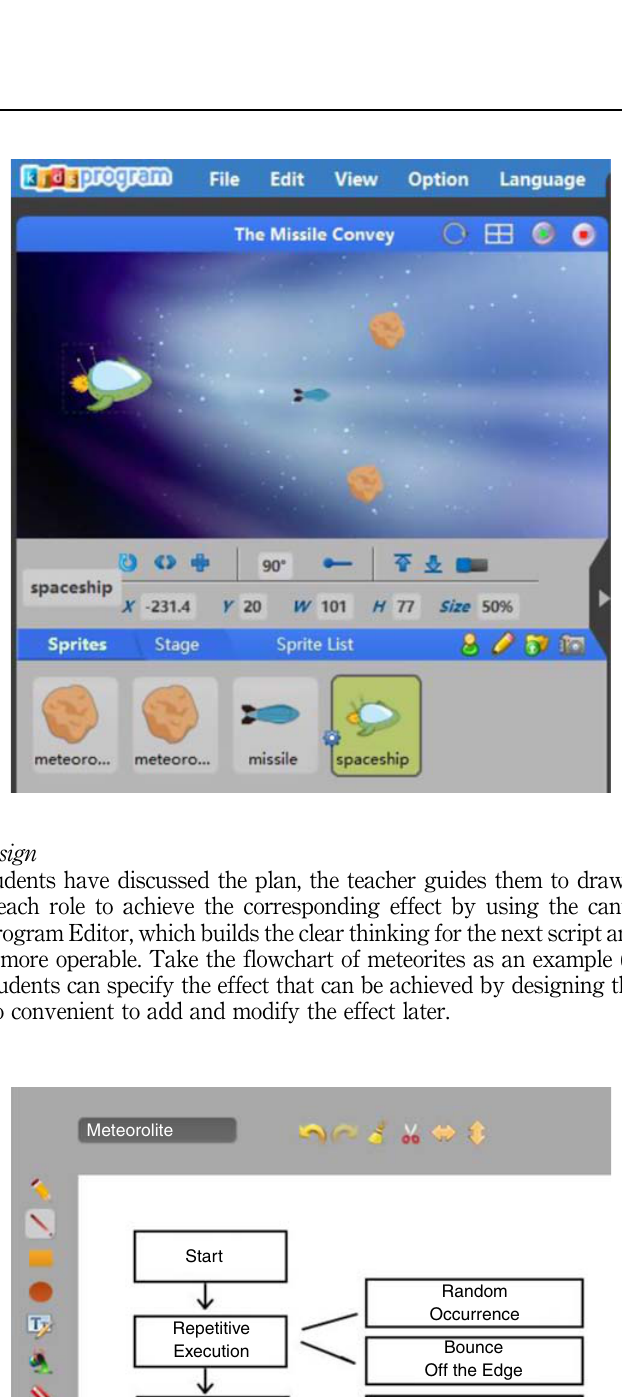
Figure 4. The flowchart of